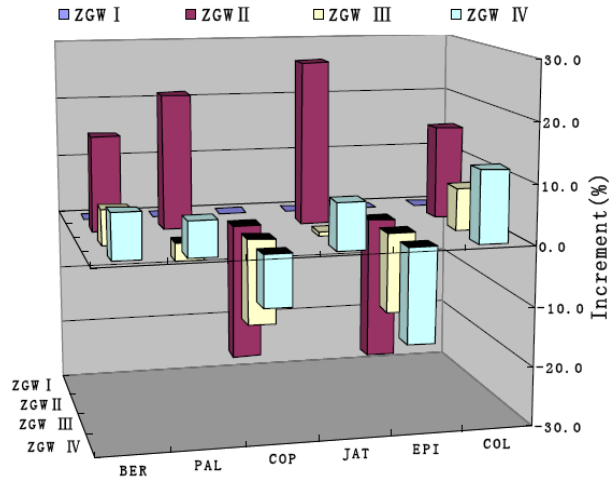
Figure 4. Influence of essential oil on the content of six alkaloids in Zoagumhwan